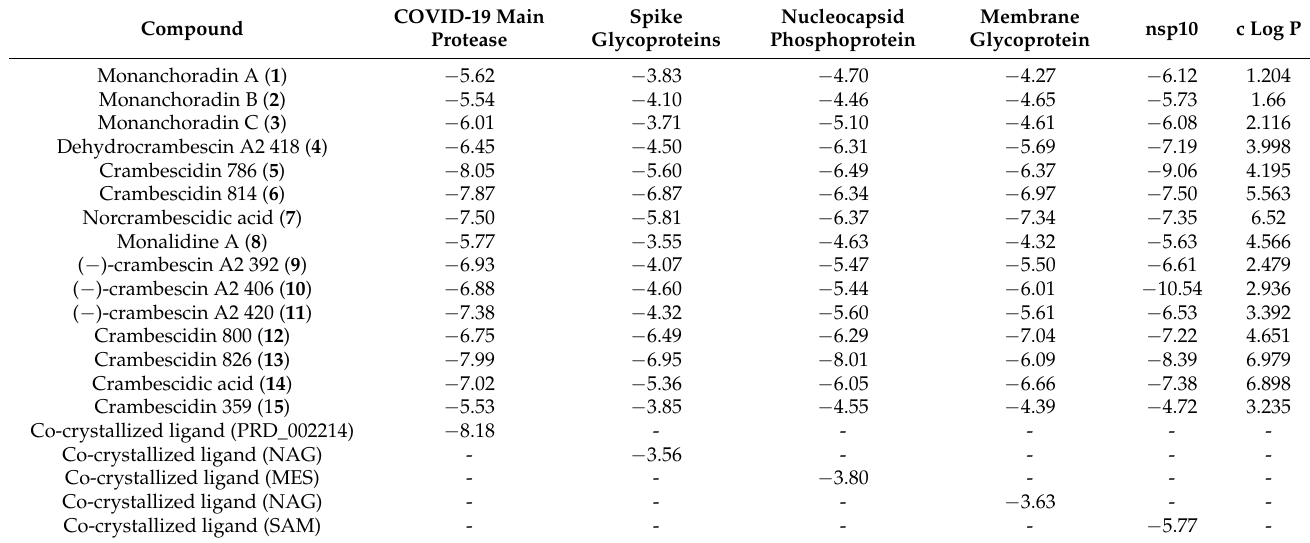
Table 1. Free energies of binding for fifteen marine guanidine alkaloids ( 1 – 15 ) to SARS-CoV-2 target proteins, and their calculated partition coefficient (c log P).